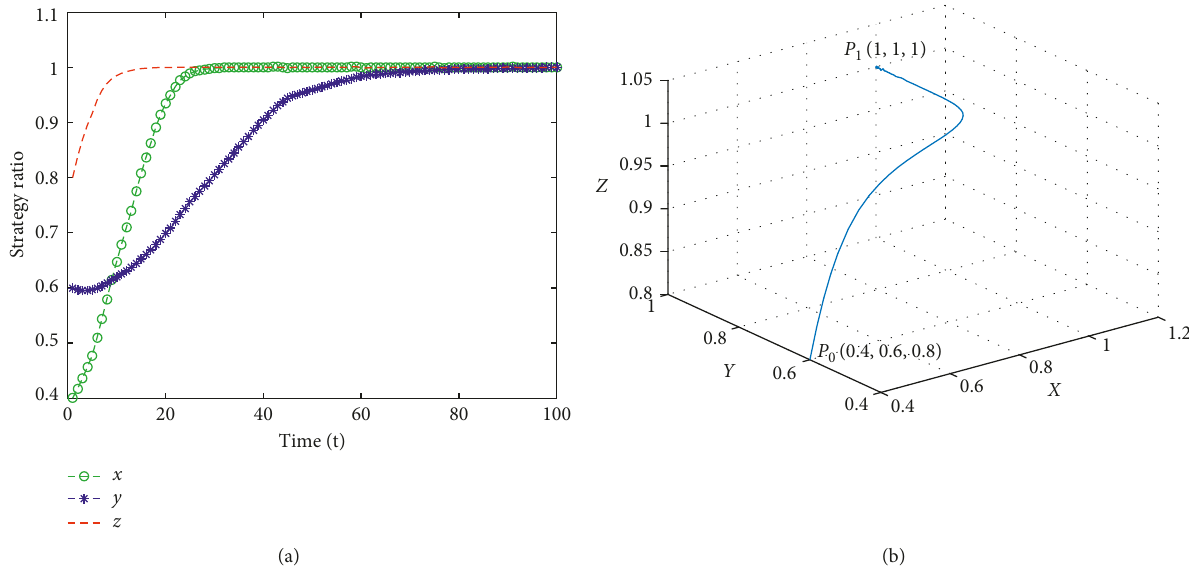
Figure 7: The dynamic evolution of the tripartite game model when x � 0 . 4 ,y � 0 . 6 , and z � 0 . 8. (a) Time evolutions of x , y , and z . (b) Time evolution of ( x , y , z